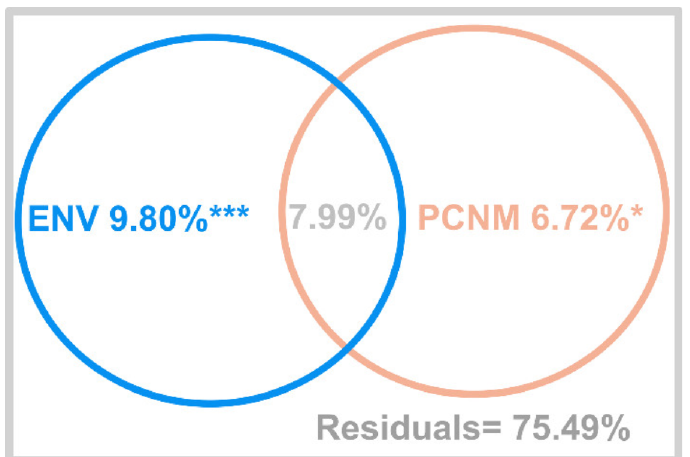
Figure 4. Variation partitioning of bacterial community composition in coastal sediments. The explanatory power of the pure and shared fractions of environment (ENV), and spatial factors (PCNM variables) are indicated as adjusted R 2 . Analysis of Variance (ANOVA) tests were carried out on the variation explained by the pure fraction. ***: p < 0.001; *: p <